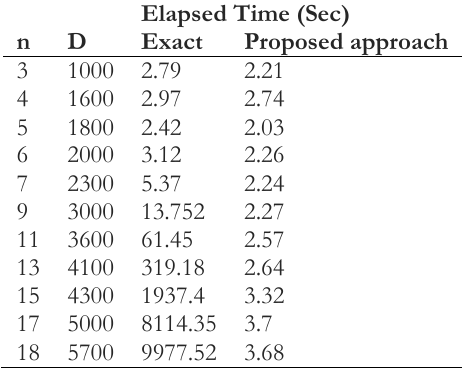
Table 6. Comparison of exact method and proposed